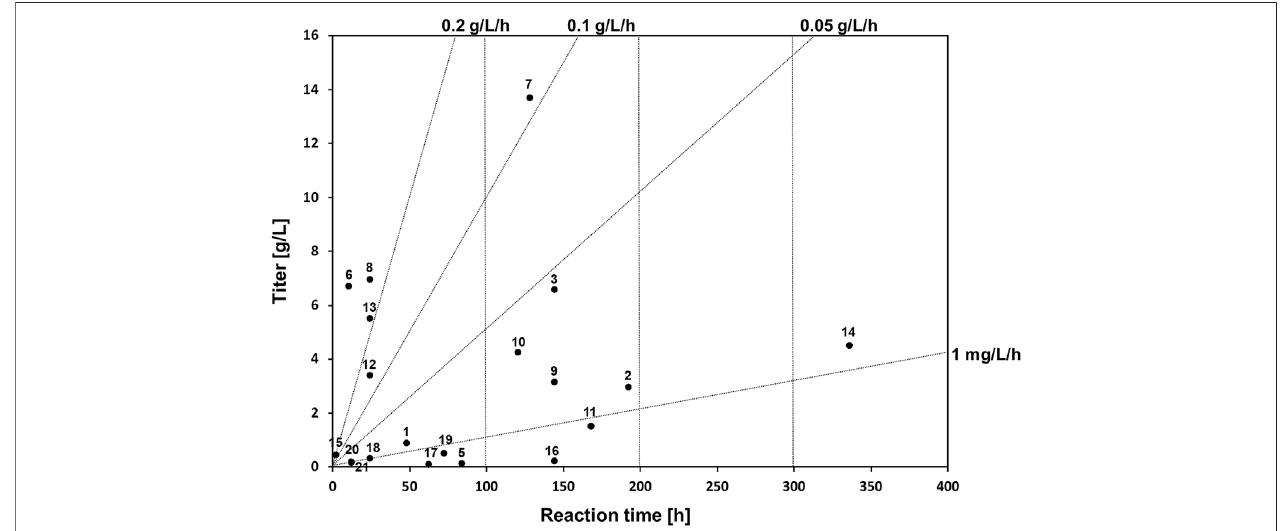
FIGURE 2 | Space-time yield analysis of whole-cell biotransformation in melanin production and reported bioreactor scale by biotransformation yields. The numbers next to the circles indicate the corresponding reference numbers in Table 1 .